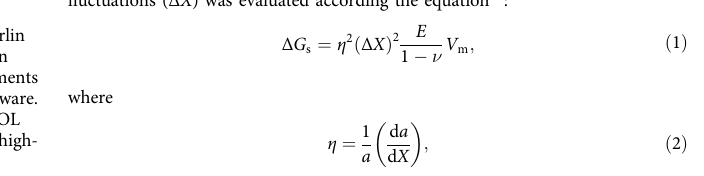
magnetic ordering based on the Inden – Hillert – Jarl formalism 50, 61 – 64 . The coherence strain energy ( Δ G s ) associated with the formation of Mn-rich regions